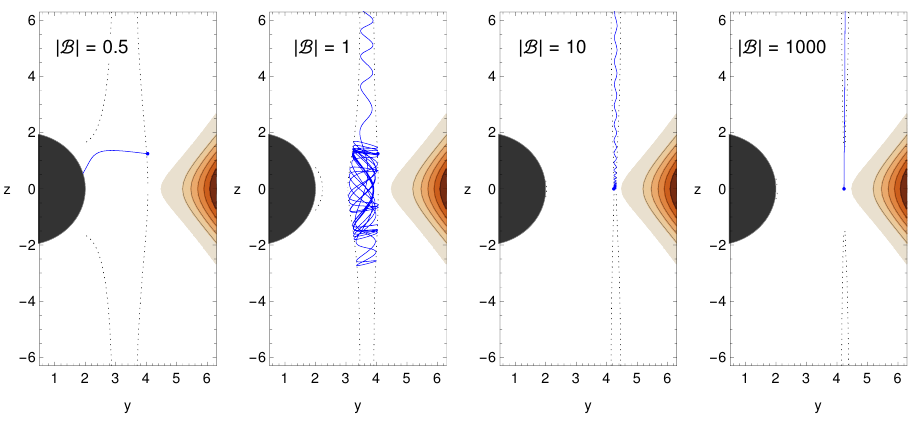
Figure 4. Charged particle chaotic scattering under the combined influence of rotating black hole and uniform magnetic